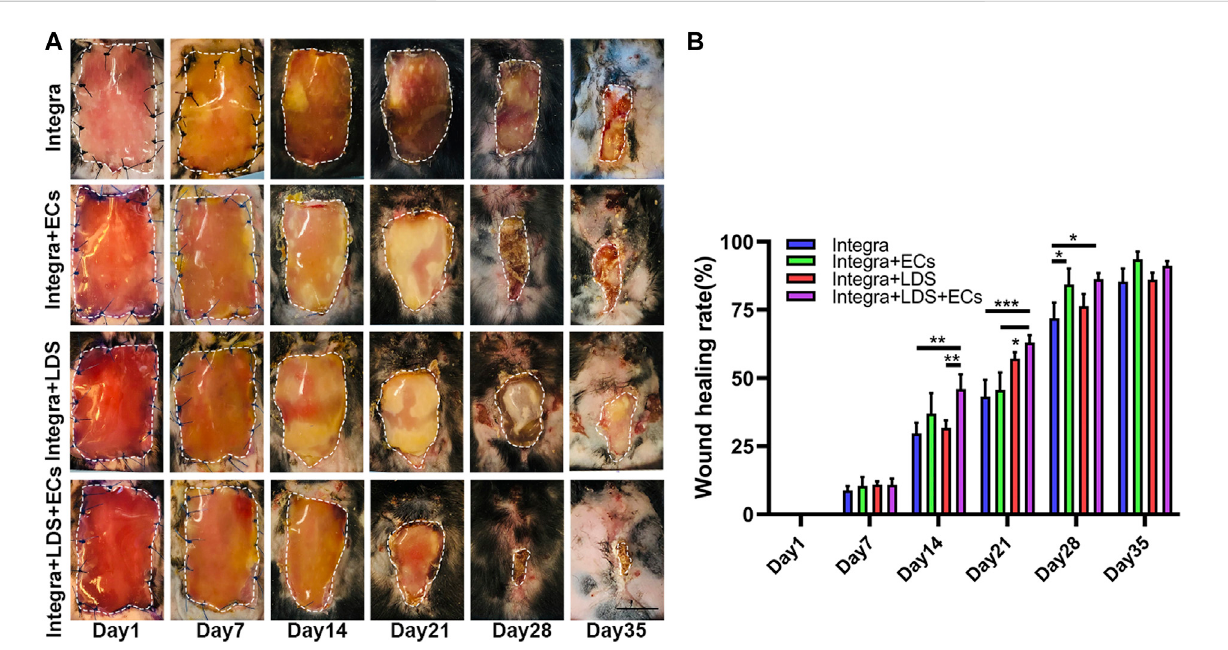
FIGURE 3 Characterization of wound healing in large deep burn wound model. The wounds were treated with Integra with ECs, Integra with LDS, or Integra with ECs and LDS, or the Integra only as standard of care. (A) Representative images of wounds in all groups during healing over 35 days. Relative wound area is indicated with white dotted line. Scale bar = 1 cm. (B) Quantitative data of wound healing rate of four groups at different time points. Data are expressed as mean ± SEM. * p < 0.05, ** p < 0.01, and *** p <